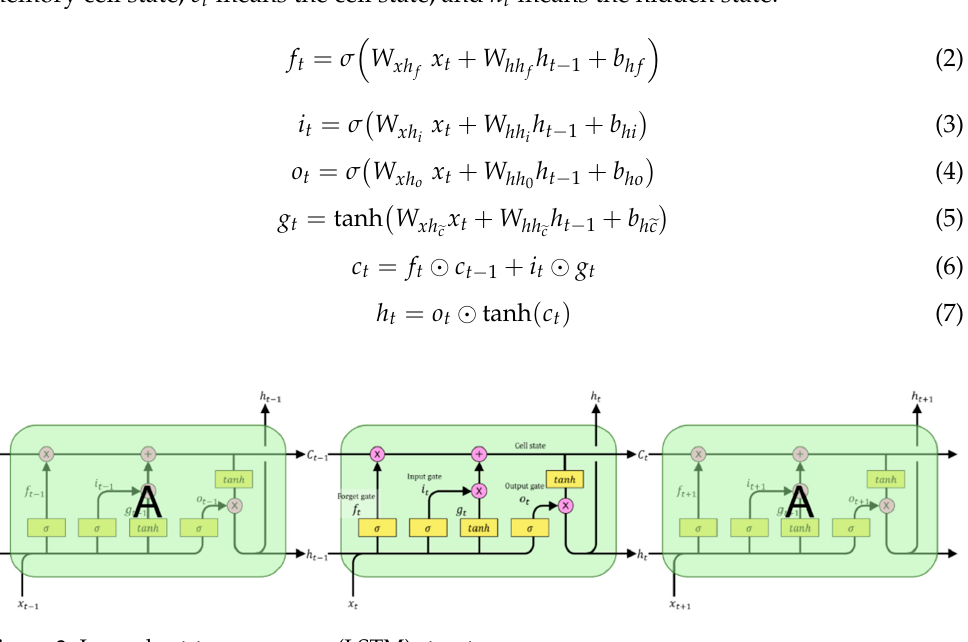
Figure 3. long short ‐ term memory (LSTM) structure. 192 Figure 3. Long short-term memory (LSTM)